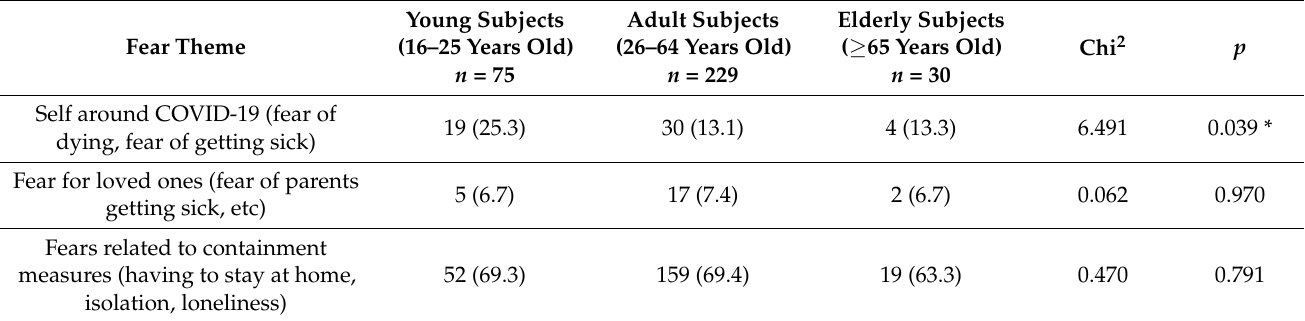
Table 3. Differences in COVID-19 related fears according to different age